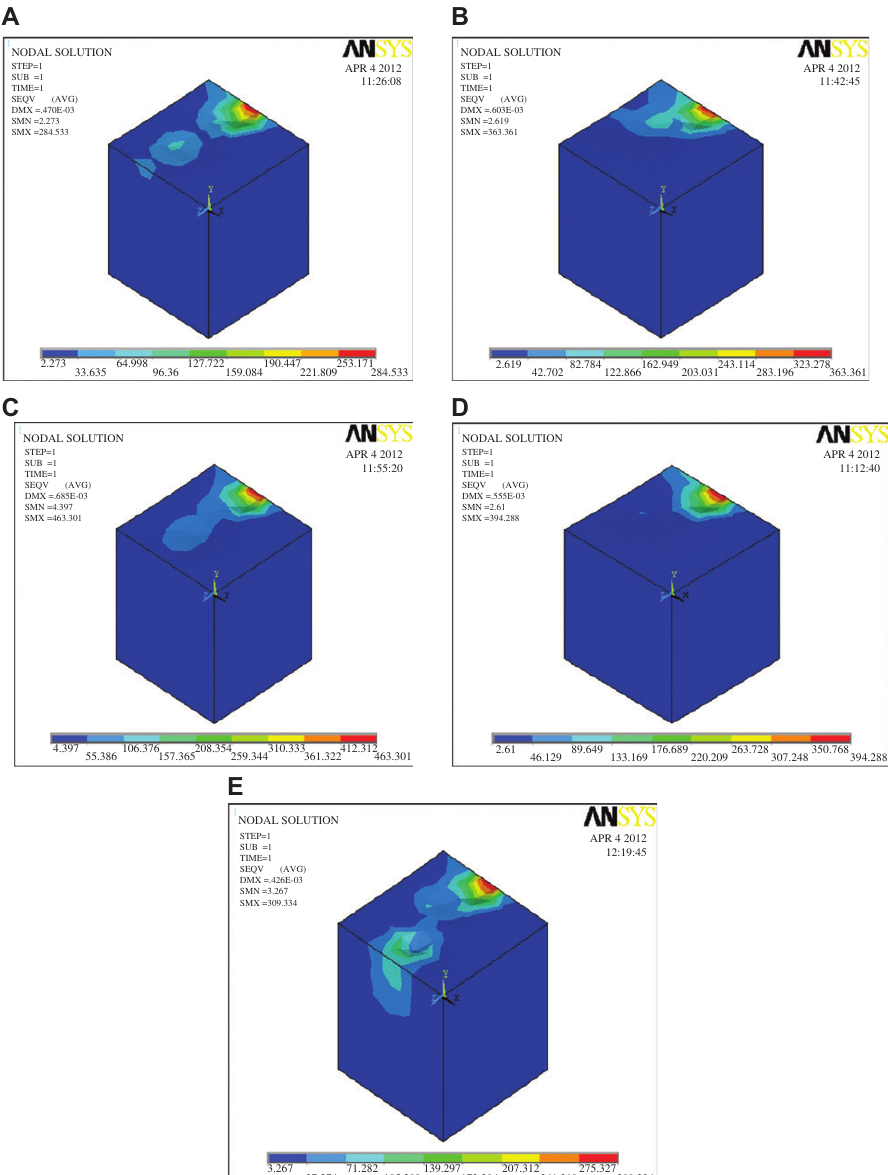
Figure 7 (A) Von-mises stress in 0 wt.- % micro-TiO alloy composites. (C) Von-mises stress in 4 wt.- % micro-TiO A384 alloy composites. (E) Von-mises stress in 8 wt.- % micro-TiO element modeling results are depicted in Figure 6 . The theoretical values of Young ’ s modulus were calculated using the equations given